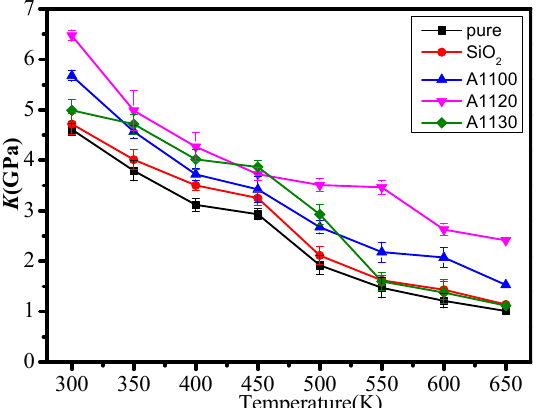
Figure 5. Shear modulus of five models at different temperatures.